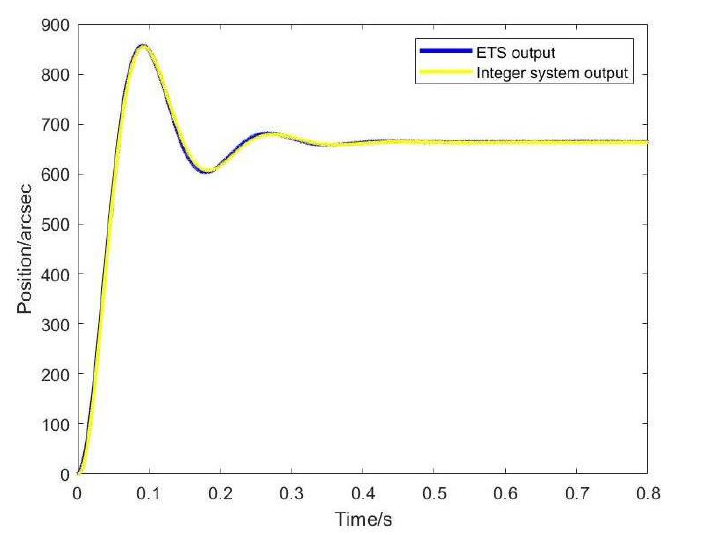
Figure 6. Integer-order system fitting.